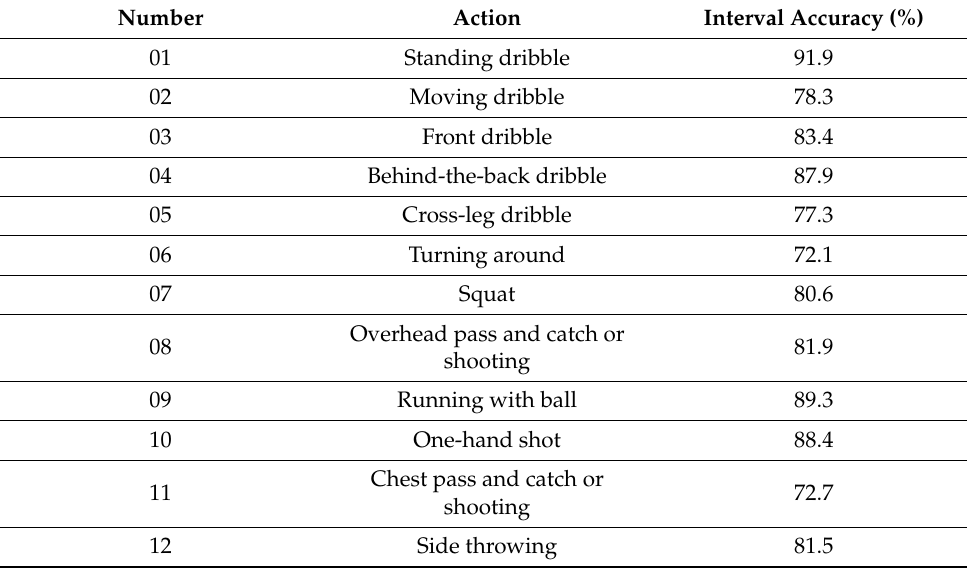
Table 6. Recognition accuracies of all action